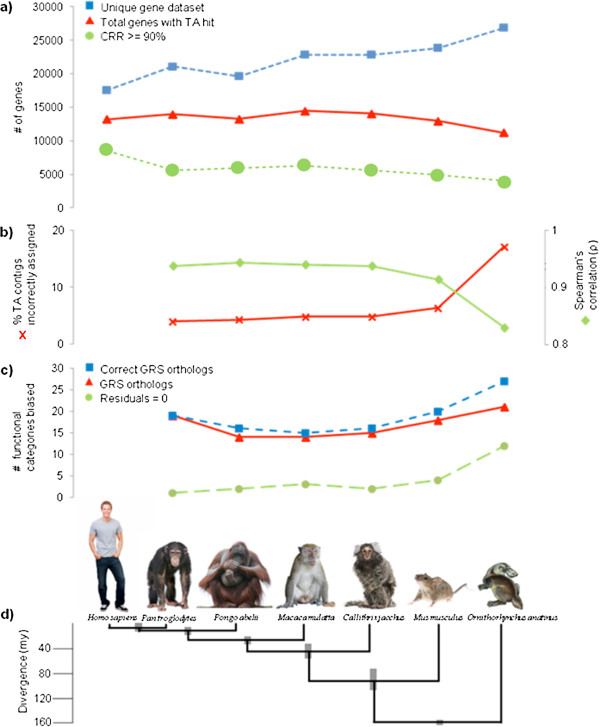
Assessment of error and bias using increasingly divergent genomic reference species as proxies. a) Number of genes in different datasets derived using either H. sapiens, or each of the six species evolutionarily divergent from H. sapiens as the genomic reference. Lines are as follows: Blue square - the total number of genes in the filtered species dataset; Red triangle - the number of genes that have TA contig hits; Green circle - Number of genes with CRR > = 90%; b) Blue diamond - Comparison of the Spearman’s correlation (ρ) for expression values obtained through annotating TA contigs using the CCDS dataset and using the proxy GRS datasets; Red squares - Level of error incurred through using divergent GRS to annotate TA measured as the percentage of TA contigs incorrectly assigned to CCDS; c) Bias obtained through using GRS as proxy datasets (number of GO and/or KEGG categories): Red triangles - GRS genes orthologous to human CCDS genes; Blue squares - subset of the GRS orthologs that have only TA contigs that are correctly assigned to them; Green circles - residuals from a graph of expression values obtained via mapping to the TA and then annotated either directly to the CCDS or to a GRS gene set. Significance is at p < 0.05 in all cases; d) Approximate divergence times of proxy GRS from H. sapiens (taken from [30-33].